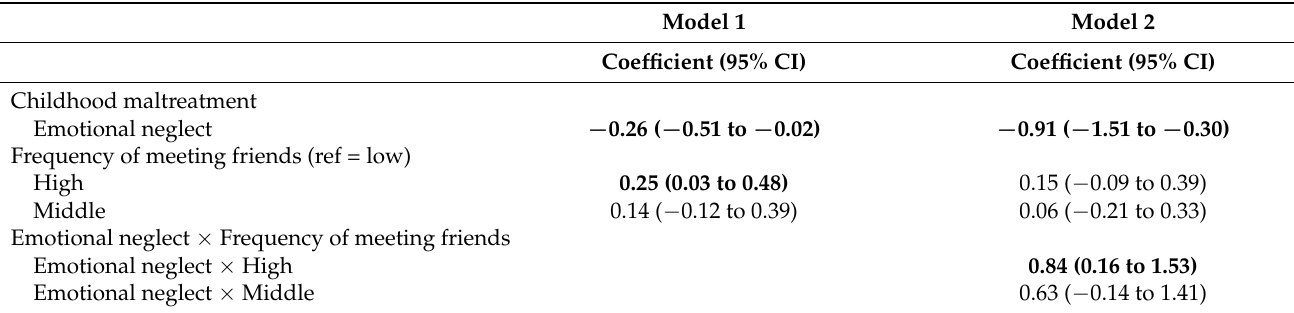
Table 4. Associations of childhood emotional neglect and frequency of meeting friends with gratitude among Japanese older adults ( n =